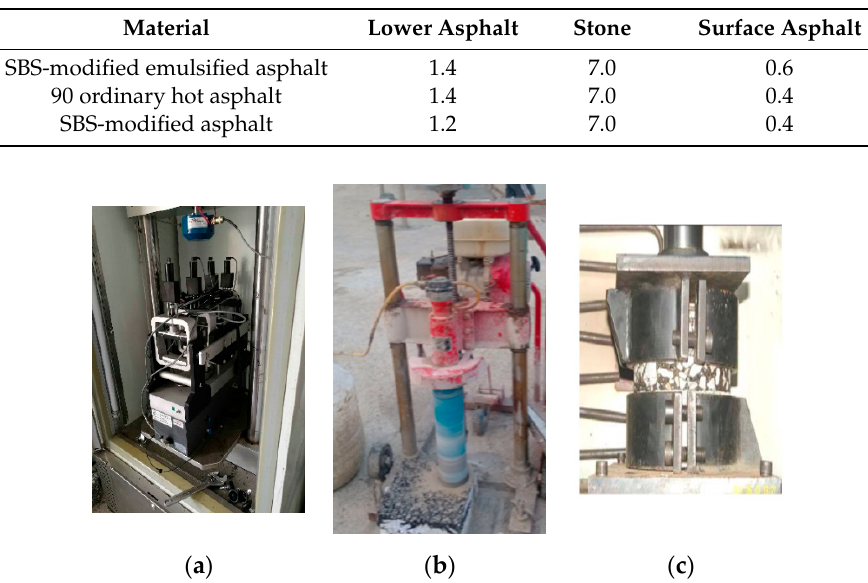
Figure 9. The forming and testing process of fatigue samples: ( a ) electro-hydraulic servo fatigue testing machine; ( b ) the sample forming process; ( c ) direct shear test with vertical load. Table 7. Waterproof cohesive layer material quantity (kg/m 2 ).